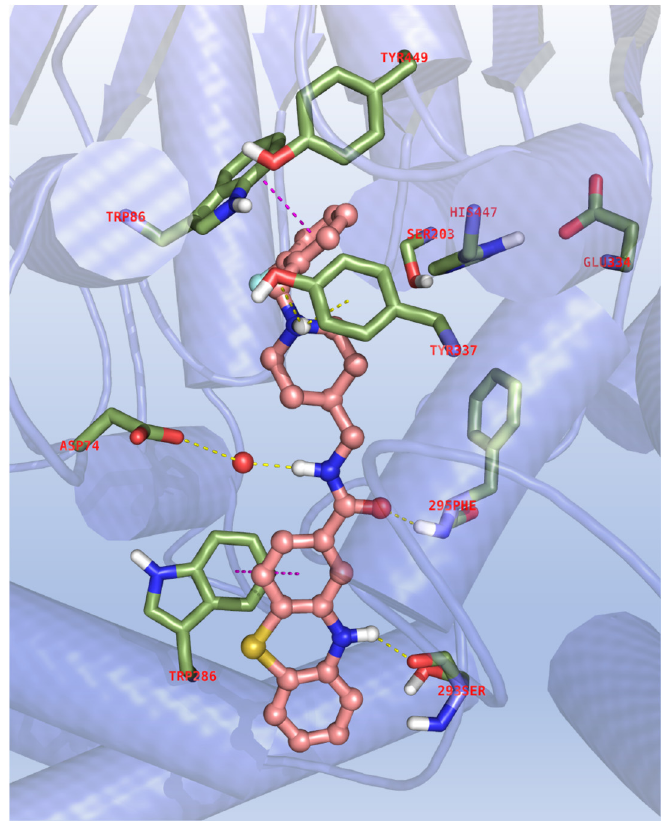
Figure 3. Binding mode for 11d to the AChE active site. In the interaction pattern scheme, hydrogen bonds and π - π stackings are depicted in yellow and magenta, respectively. bonds and π - π stackings are depicted in yellow and magenta, respectively.